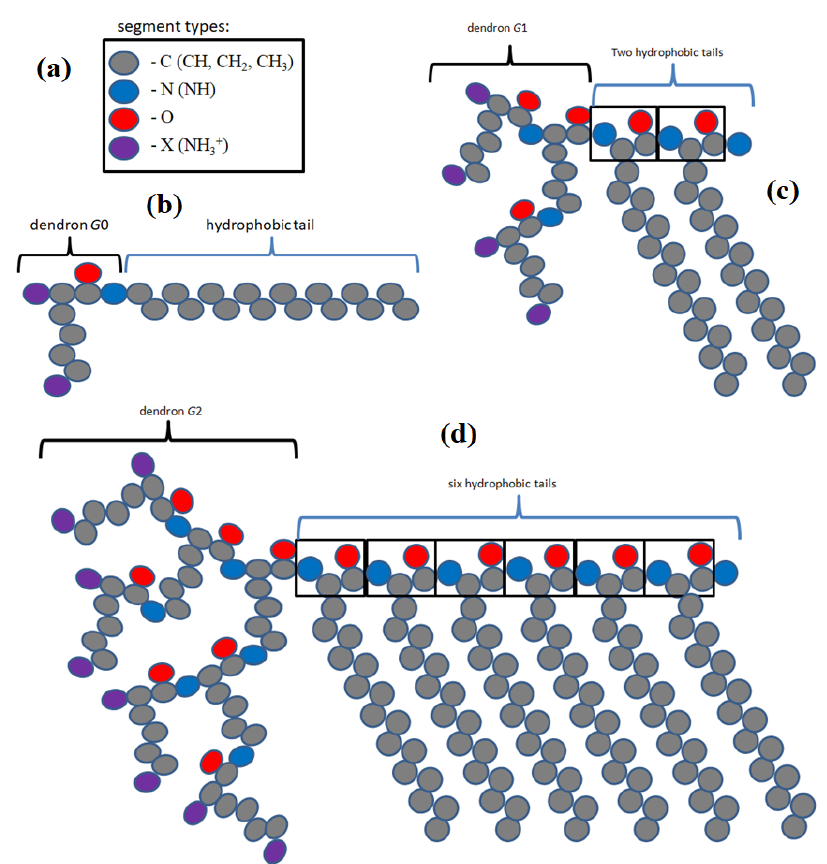
Figure 14. The united atom model: ( a ) segment types in hybrid molecules, ( b ) the model with single chain ( t = 1) and G = 0 [9], ( c ) the model with two chains ( t = 2) and G = 1 [10], and ( d ) the model with six chains ( t = 6) and G = 2 [10]. Each tail on this graph consists of 16 CH 2 , i.e., N t = 16. Table 1. ( a ): a set of Flory-Huggins interaction parameters χ between two distinct segments. The segment types W (water), C (CH, CH 2 , CH 3 ), charged units are surfactant NH + the generic co-ion Na + and counterion Cl − . ( b ): valency v X of the segments X , and relative dielectric permittivity ε rX